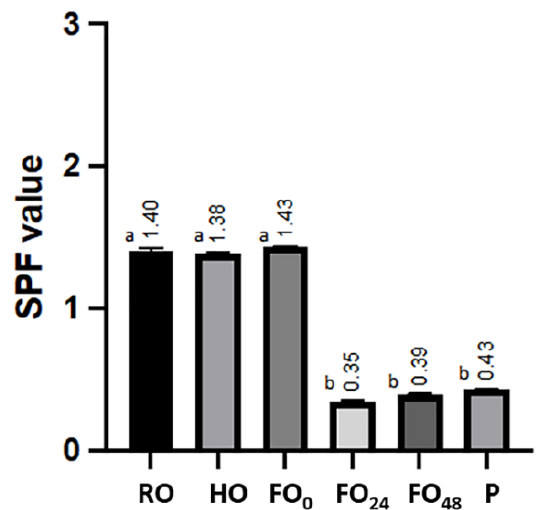
Figure 11. SPF values calculated for raw (RO), hydrolyzed (HO), and fermented oatmeal samples obtained at time 0, and after 24 h, 48 h, and deactivation process (FO 0 , FO 24 , FO 48 , and P, respectively). Each result is a mean value of a triplicate analysis and error bars indicate the corresponding standard deviations. Values marked with different lowercase letters are significantly different ( p < 0.05), according to Tukey’s test .